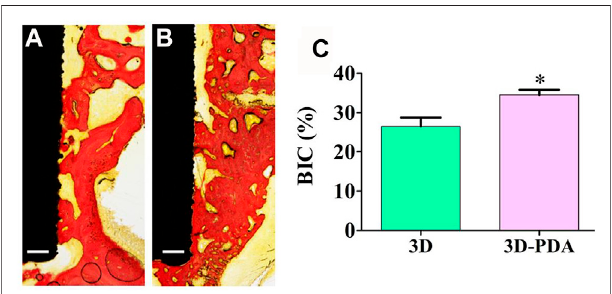
FIGURE 4 | Histological images of hard-tissue slicing of 3D (A) and 3D- PDA (B) implants after implantation at week 4, scale bar (cid:2) 200 μ m, histomorphometry quantitive analysis of BIC percentages on implant surfaces (C) ; * p <